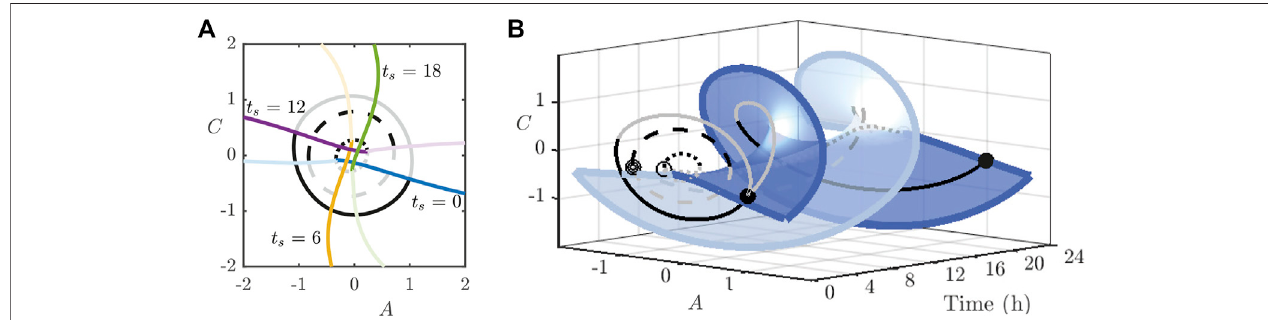
FIGURE 10 | (A) : Intersection of the strong stable manifolds (dark coloured) of the stable periodic orbit and stable manifolds (light coloured) of the saddle periodic orbit for the indicated values of t s . The projection of each periodic orbit (black and grey) onto this plane of zero phase is also shown. We see that the manifolds rotate around each orbit as t s is varied, as evidenced by comparing the manifolds with t s (cid:1) 0 and t s (cid:1) 12. (B) : Strong stable manifolds of the stable limit cycle (dark blue) and stable manifolds of the saddle limit cycle (light blue) along the entire 24 h forcing